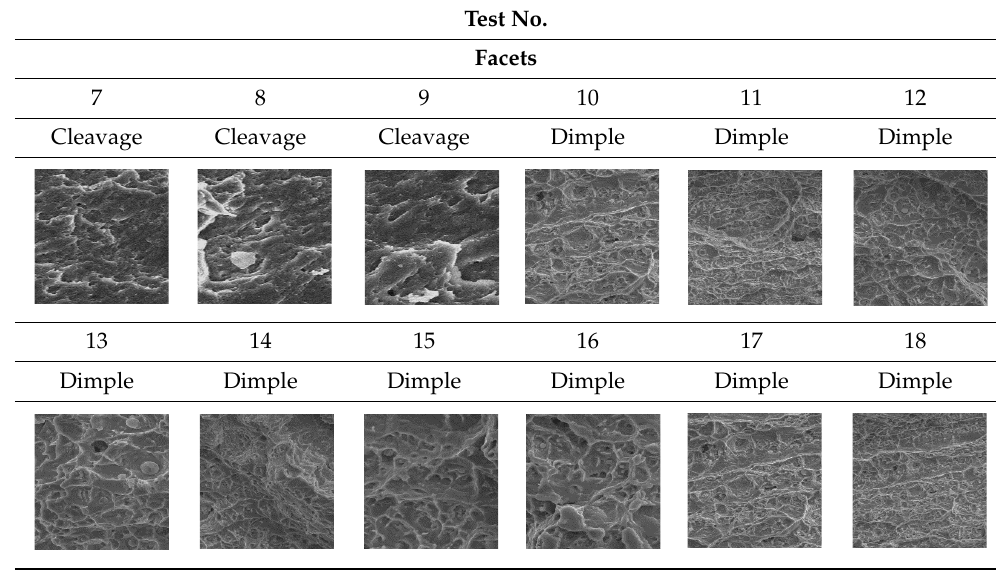
Table 8. Results of fracture behavior according to heat input in flux core arc welding. Test No.